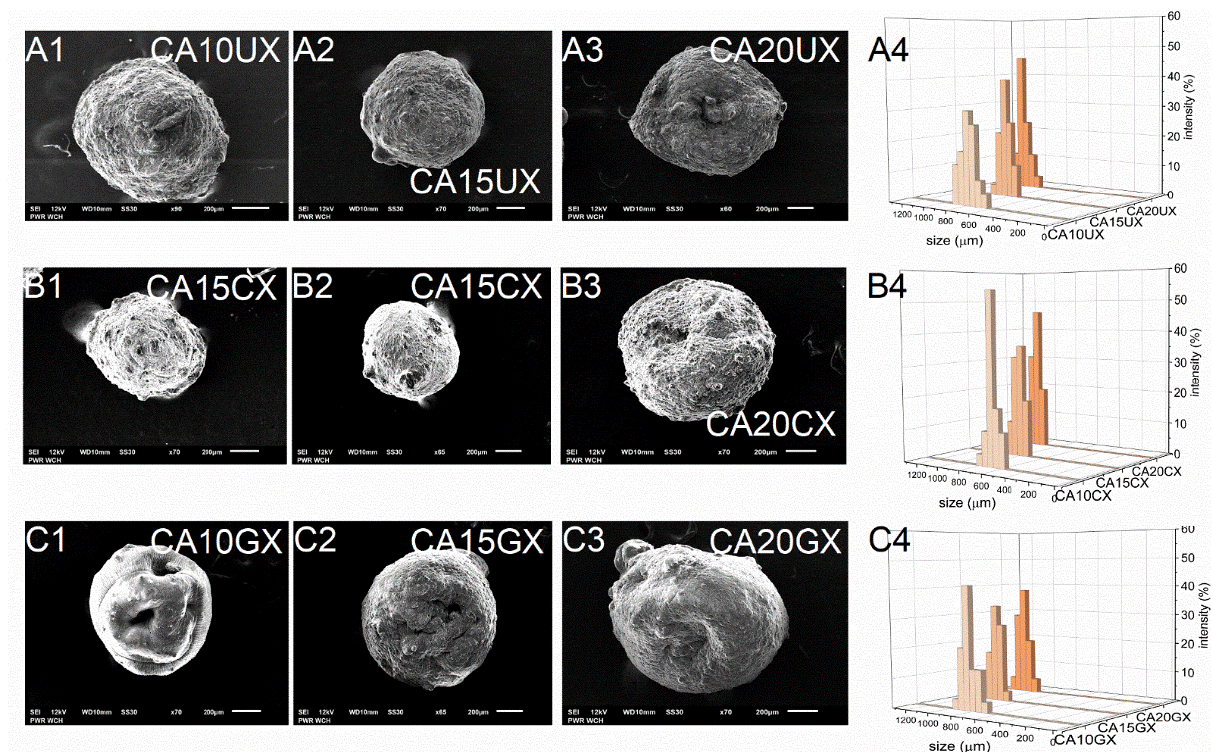
Figure 3. Scanning electron microscopy ( A1 – A3 , B1 – B3 , C1 – C3 ) and size distribution ( A4 , B4 , C4 ) images of CUR-loaded macroparticles (see Table 1 for details of the particle composition).